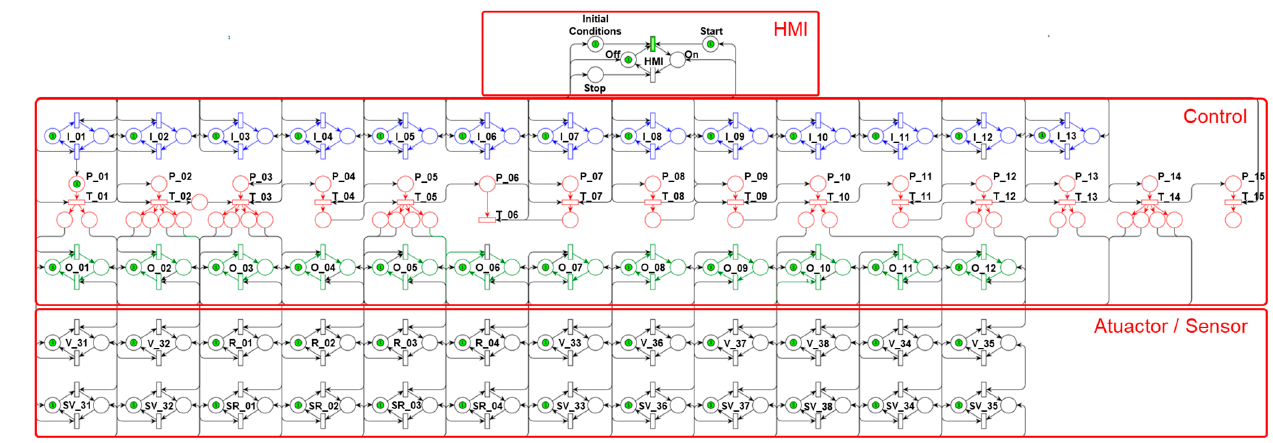
Figure 8. Complete Petri Nets for the purge system.